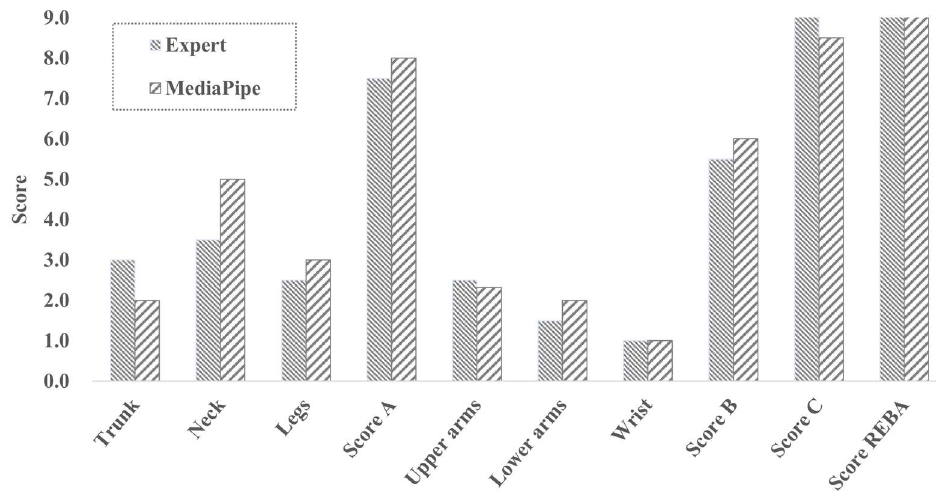
Figure 41. Comparison of heavy load working posture scores.